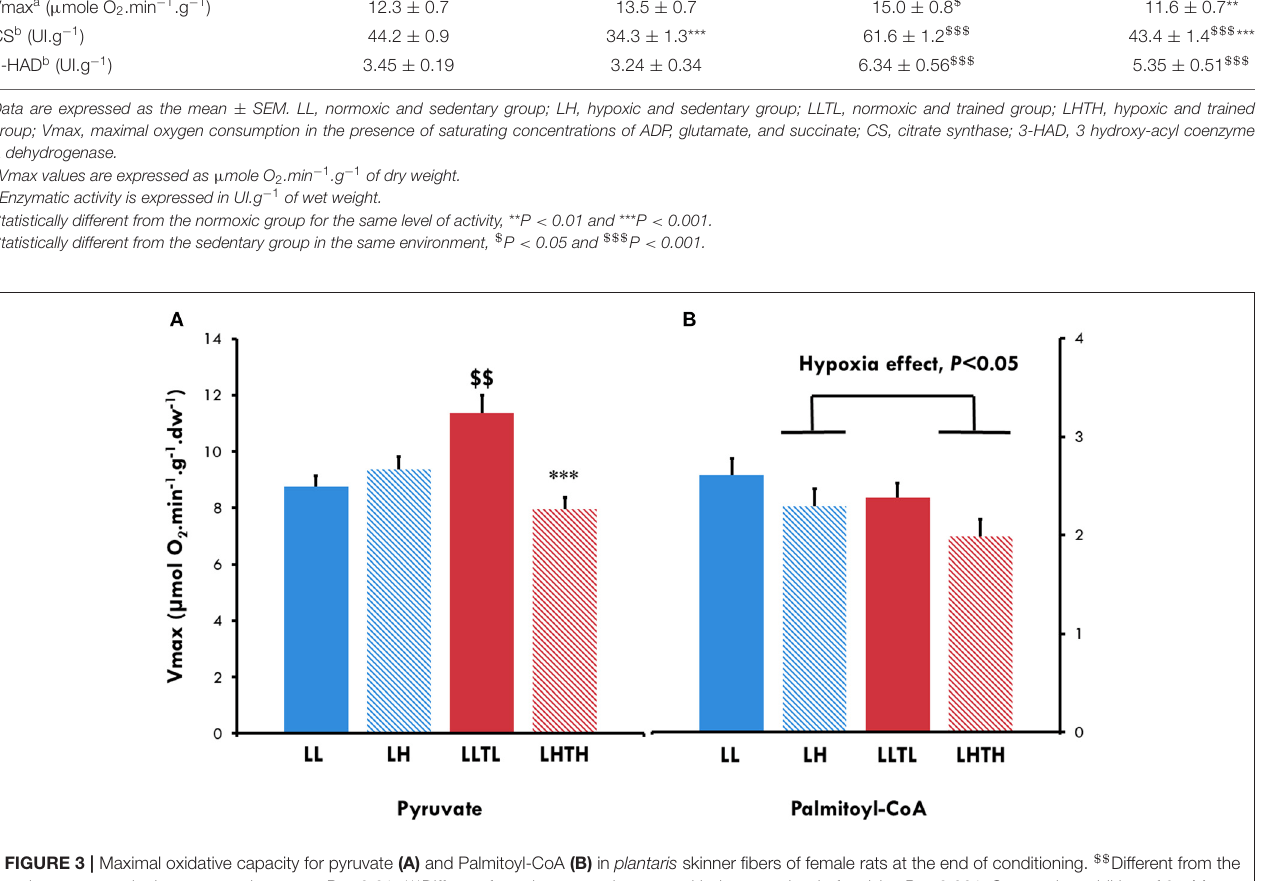
( Table 5 ) by studying the acceptor coupling ratio (ACR)